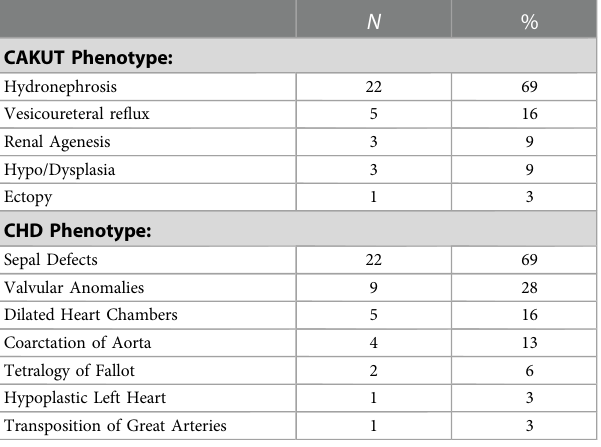
TABLE 4 CAKUT and CHD phenotype*.